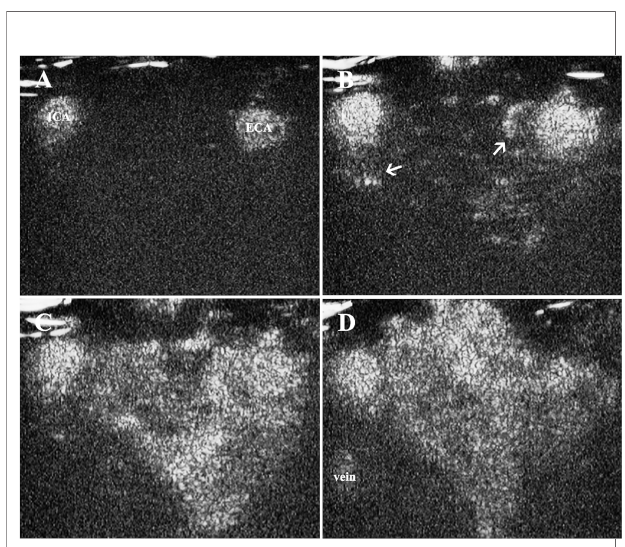
FIGURE 2 | Contrast enhancement in CBT lesion area. (A) Contrast enhancement was fi rstly observed in carotid arteries, (B) followed by the enhancement of tumor feeding vessels deriving from ECA and ICA (thin arrows) 10 s after the injection of the contrast agent. (C) The contrast agents then diffused rapidly from feeding vessels and exhibited progressing enhancement in the solid area. (D) The signal intensity decreased within the carotid arteries and solid area of the tumor, and the enhancement could be observed in the jugular veins. CBT, carotid body tumor; ICA, internal carotid artery; ECA, external carotid